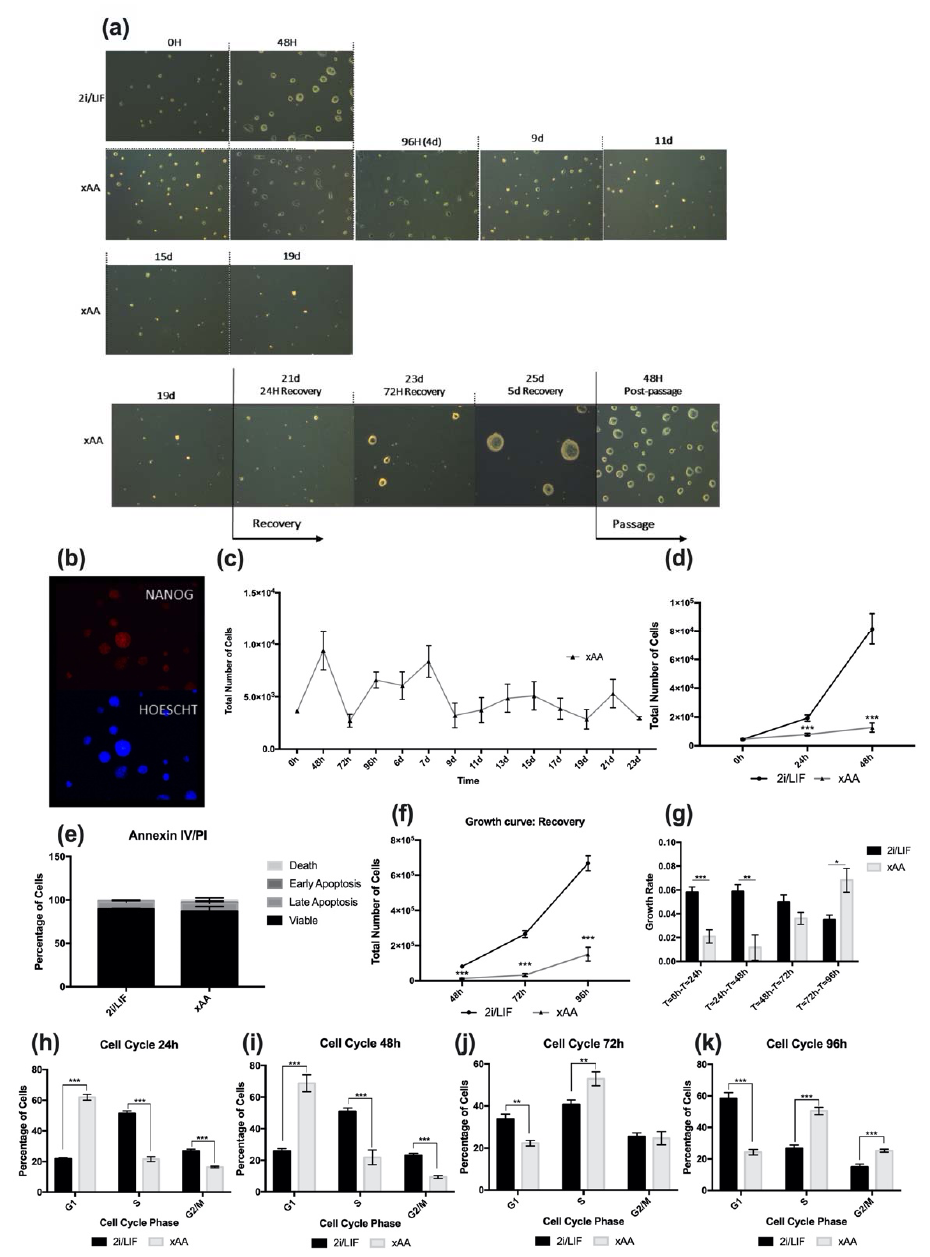
Figure 1. 2i mESCs can be maintained in long-term culture in the absence of Leucine and Argi- nine. ( a ) Representative images acquired from randomly selected fields using phase contrast mi- croscopy (100 × magnification). Images include: 1—cells cultured in 2i/LIF medium for 48 h